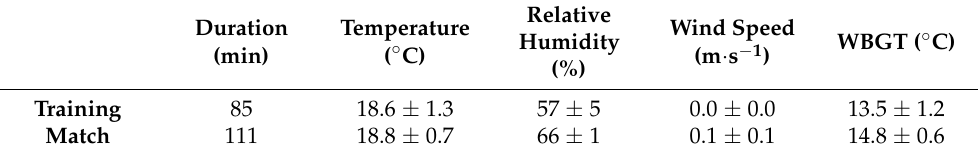
Table 1. Environmental conditions for the training and match (mean ± SD).